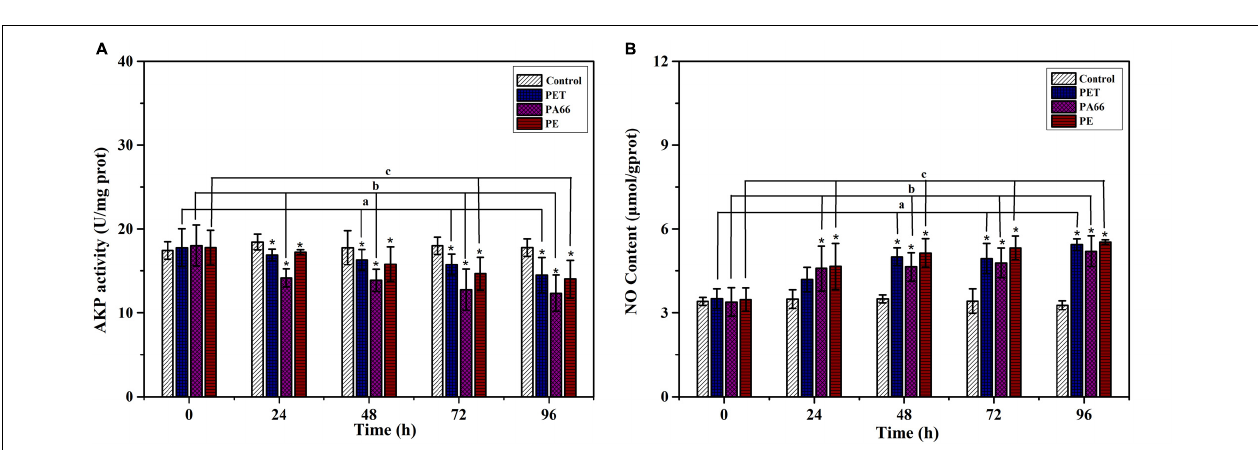
FIGURE 5 | Immune ability analysis. AKP activity (A) and NO content (B) in the coral exposed to different MPs (PET, PA66, and PE 50 mg/L, respectively) for 0, 24, 48, 72, and 96 h. All data are presented as mean ± standard error ( N > 3). Asterisk (*) represent a significant difference from normal (* p < 0.05).